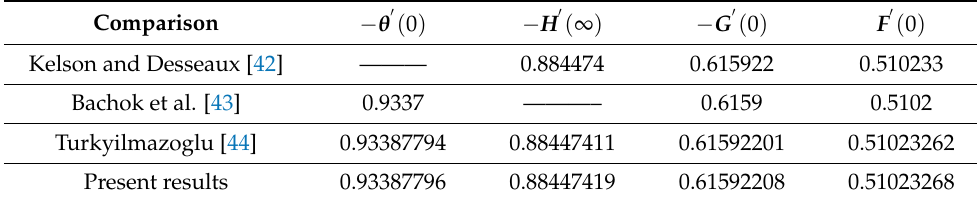
Table 2. Comparison of the F (cid:48) ( 0 ) , − G (cid:48) ( 0 ) , − H (cid:48) ( ∞ ) and − θ (cid:48) ( 0 ) values for some reduced cases with available reported published